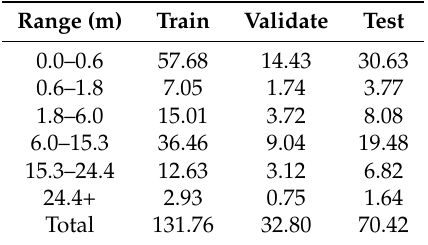
Table 1. Amount of pixels (millions) in each dataset, presented in specified height ranges of interest. The training and validation datasets were used in Y-NET’s training process, while the testing dataset was used for our